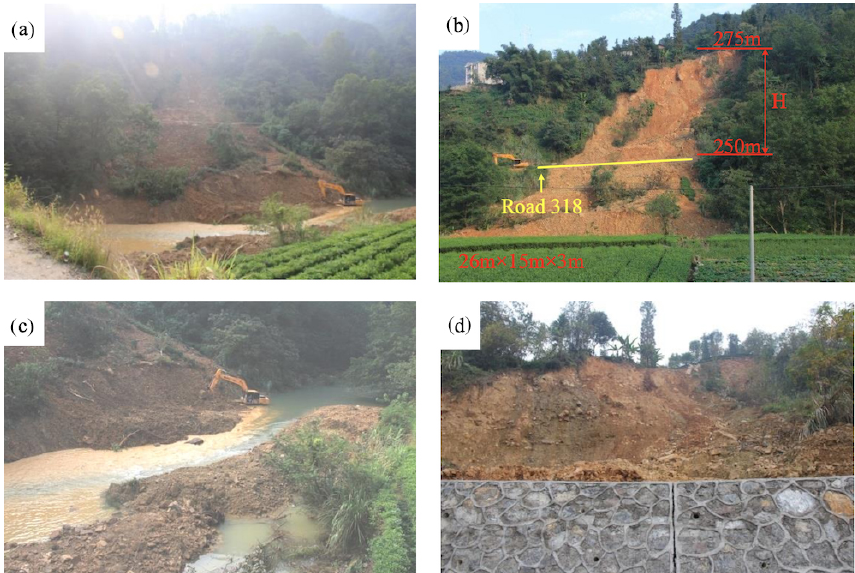
Figure 2. Landslide YYG01 occurred in the rainy season of 2013, causing damage on the national road (G318) in Yuyangguan. (Travel distance = 57m.) (a) An overview of the landslide YYG01, (b) left side of the loose landslide body, (c) river blockage caused by the landslide YYG01, and (d) the retaining wall.